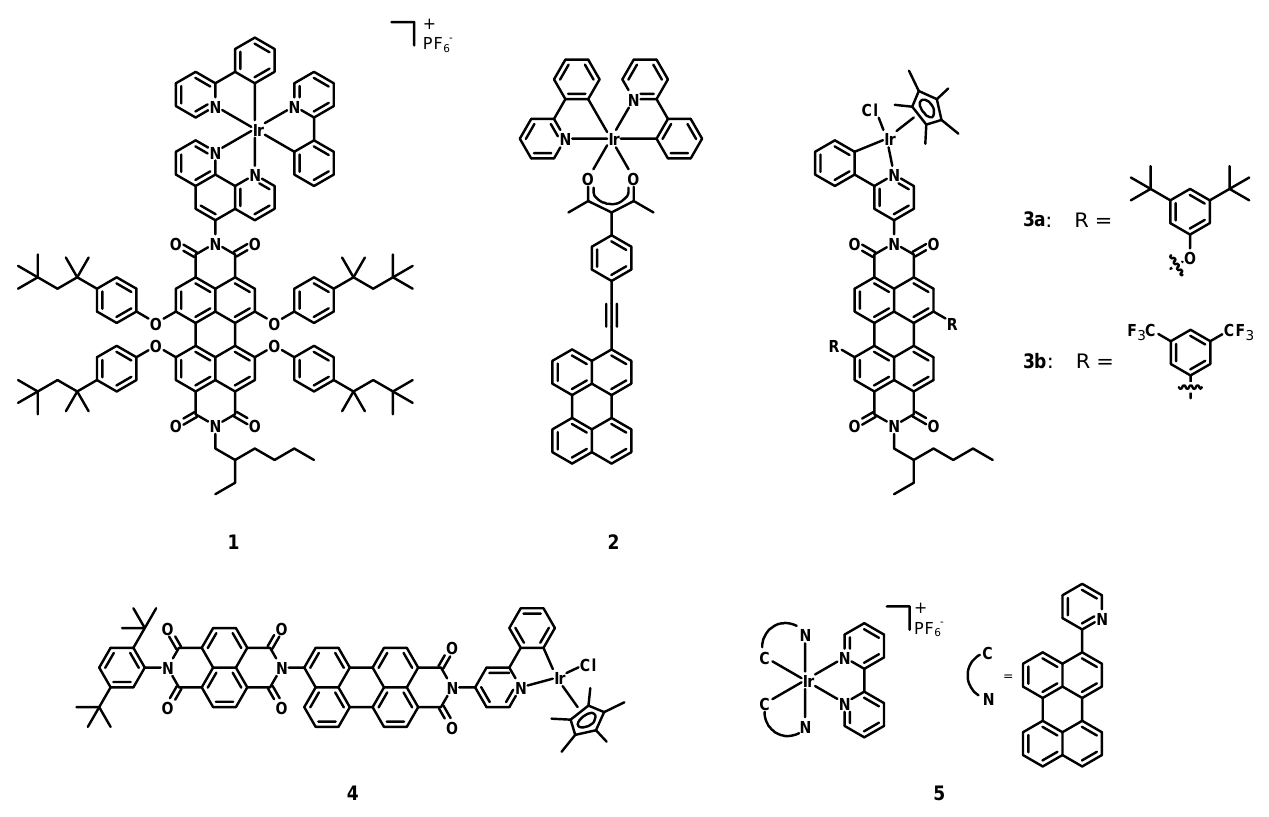
Figure 3. Structures of complexes 1 , 2 , 3a – b , 4 , and 5 . Table 1. Photophysical and redox properties of complexes 1 , 2 , 3a – b , 4 , 5 , 6a – b , 7 , and 8a – b . Complex